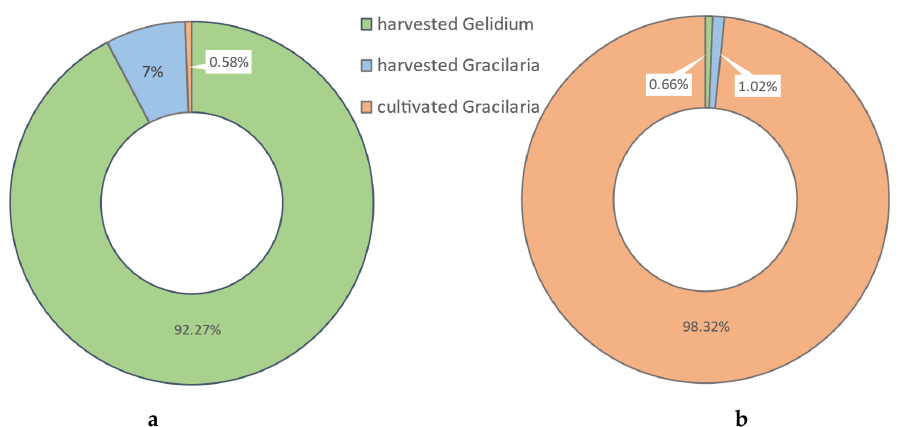
Figure 6. Percentage of agar market use in 1996 ( a ) and 2020 ( b ) of wild Gelidium biomass, wild Gracilaria biomass, and cultivated Gracilaria biomass. Cultivated Gelidium biomass was not in the market in these years. Data from FAO [44].